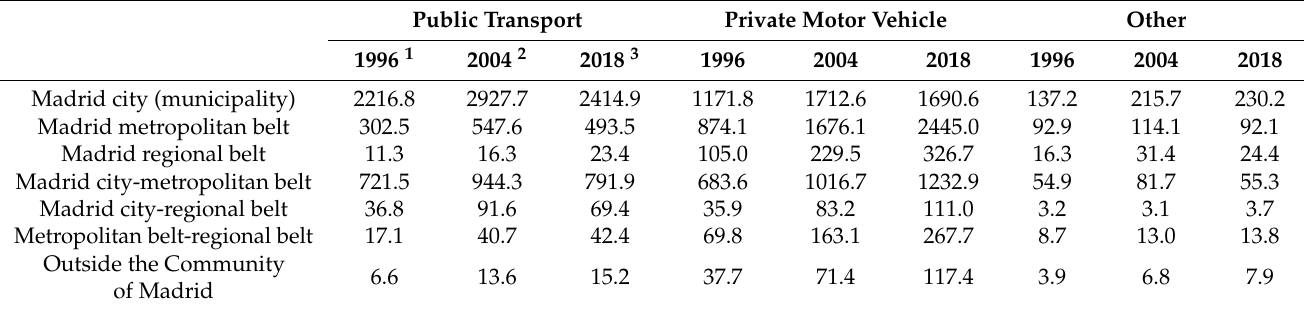
Table 4. Evolution of daily trips (thousands) within and between the Madrid municipality, its metropolitan belt, its regional belt, and outside the Community of Madrid (i.e., beyond the boundaries of the province and autonomous community) in 1996, 2004 and 2018. Source: EDM (1996, 2004, and